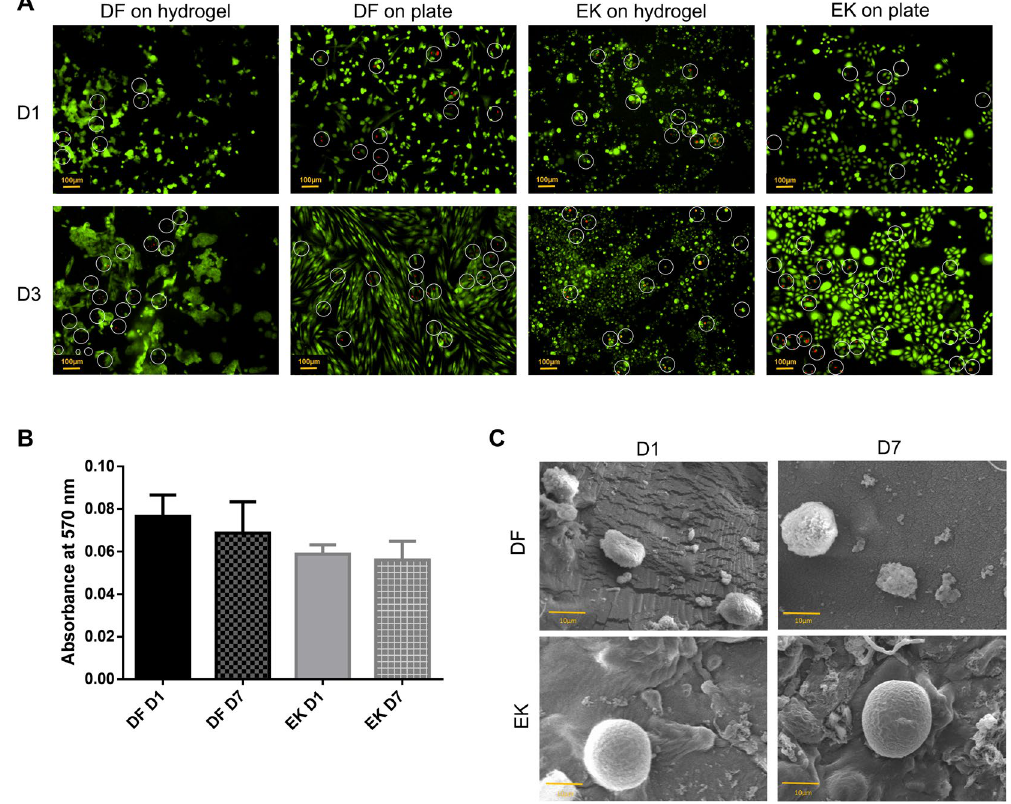
Figure 2. ( A ) Live (green) and dead (red) assay of dermal fibroblasts (DF) and epidermal keratinocytes (EK) on hydrogel and polystyrene cell culture plates at day 1 (D1) and day 3 (D3) under 100 × magnification. The white line circle indicates the dead cells ( B ) Cell proliferation of DF and EK on the hydrogel at day 1 and day 7 (D7) quantified by using MTT assay. No significant difference was observed at D1 and D7 (p > 0.05) ( C ) SEM images of DF and EK on the hydrogel at day 1 and day 7 under 700 × magnification and 13